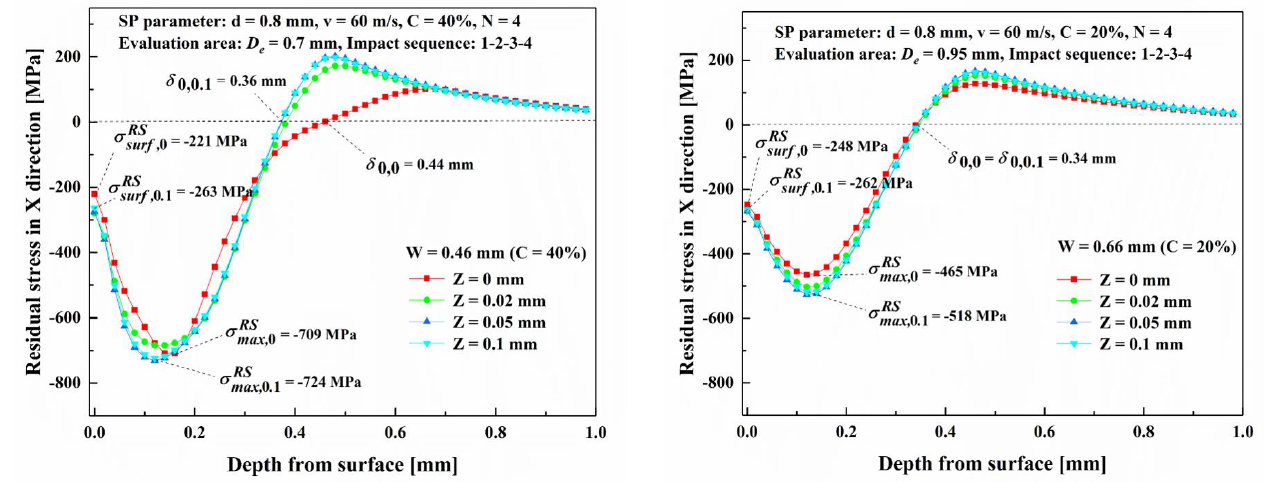
Figure 8. The residual stress depth profiles of four different vertical distance between shots (Z) SP models in the condition of ( a ) V = 60 m/s, d = 0.8 mm and C = 40% (W= 0.46 mm) and ( b ) V = 60 m/s, d = 0.8 mm and C = 20% (W = 0.66 mm).